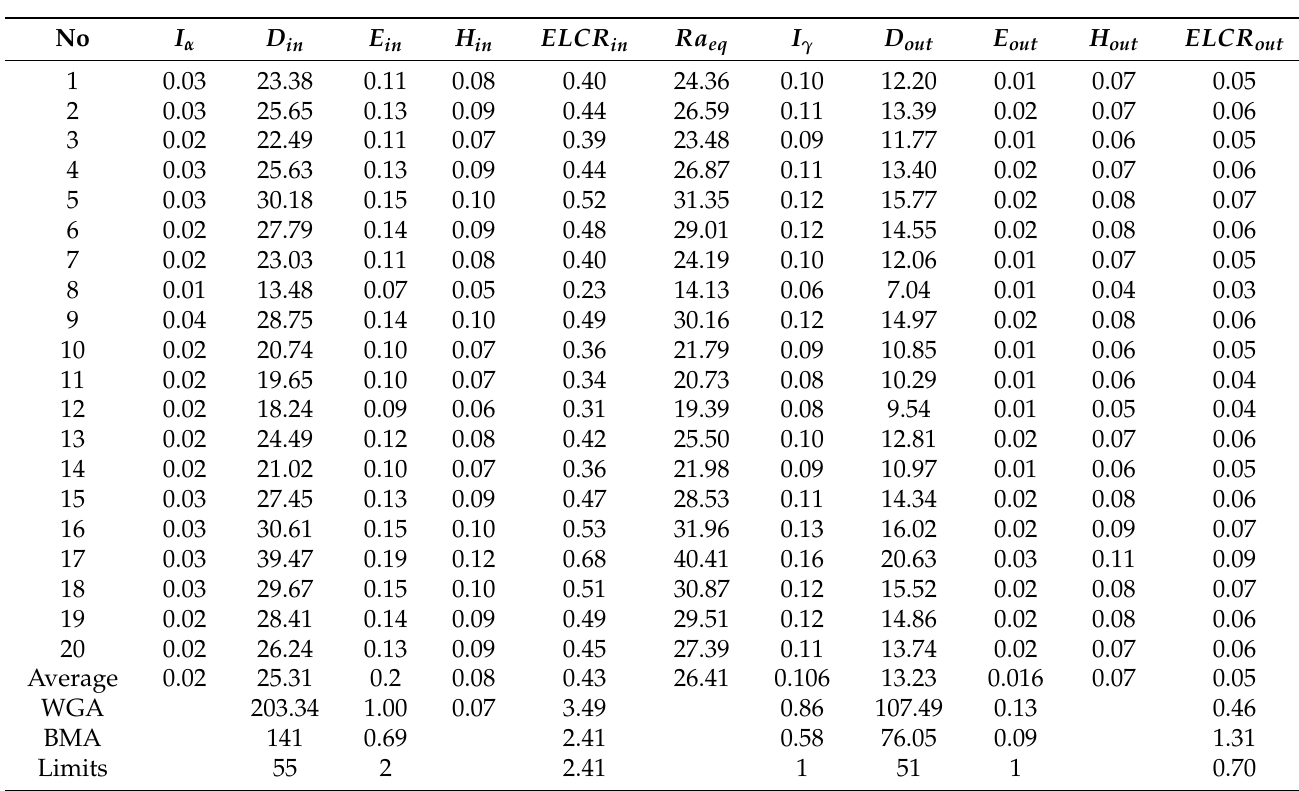
Table 3. Health hazard indices of Bajaur Norite. The first column is sample number while the next five column are Indoor Health Hazard Indices, whereas the last five columns show Outdoor Health Hazard Indices. Furthermore, the following abbreviations are used: WGA = World Granites Averages, BMA = Building Material